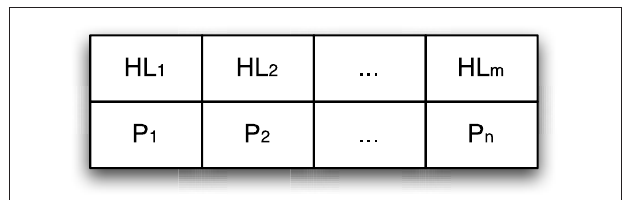
FIGURE 1 | Illustration of the solution representation. HL denotes the half-laps before riders transition, and P indicates the power output of the lead rider for per half